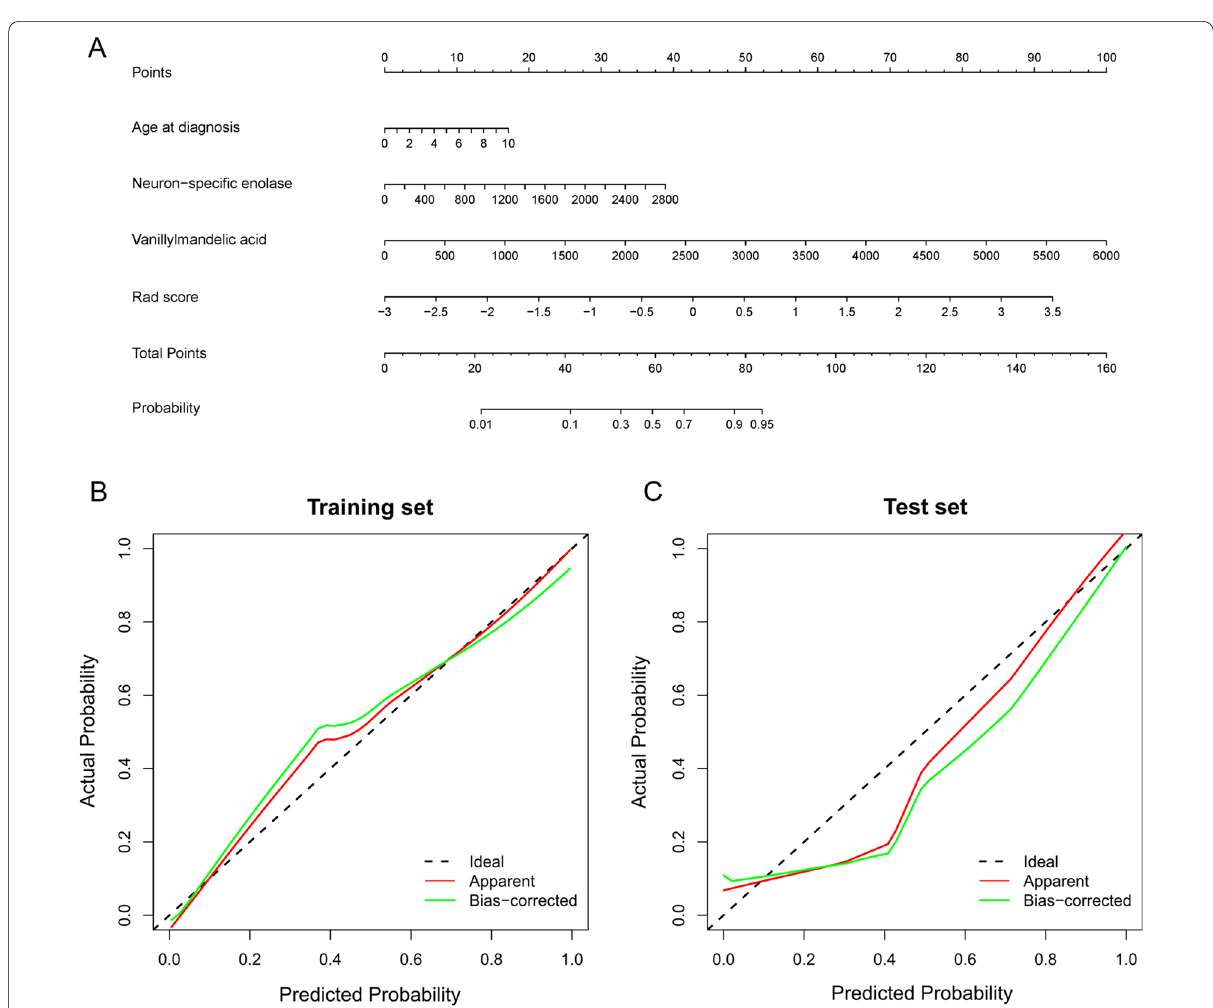
Fig. 5 A Radiomics nomogram for non-invasively prediction of bone marrow involvement (BMI) in pediatric patients with neuroblastoma. The radiomics nomogram was a visual representation of the clinical-radiomics model in the training set, which incorporated the Rad score, age at diagnosis, neuron-specific enolase and vanillylmandelic acid. B Calibration curves of the nomogram in the training set. C Calibration curves of the nomogram in the test